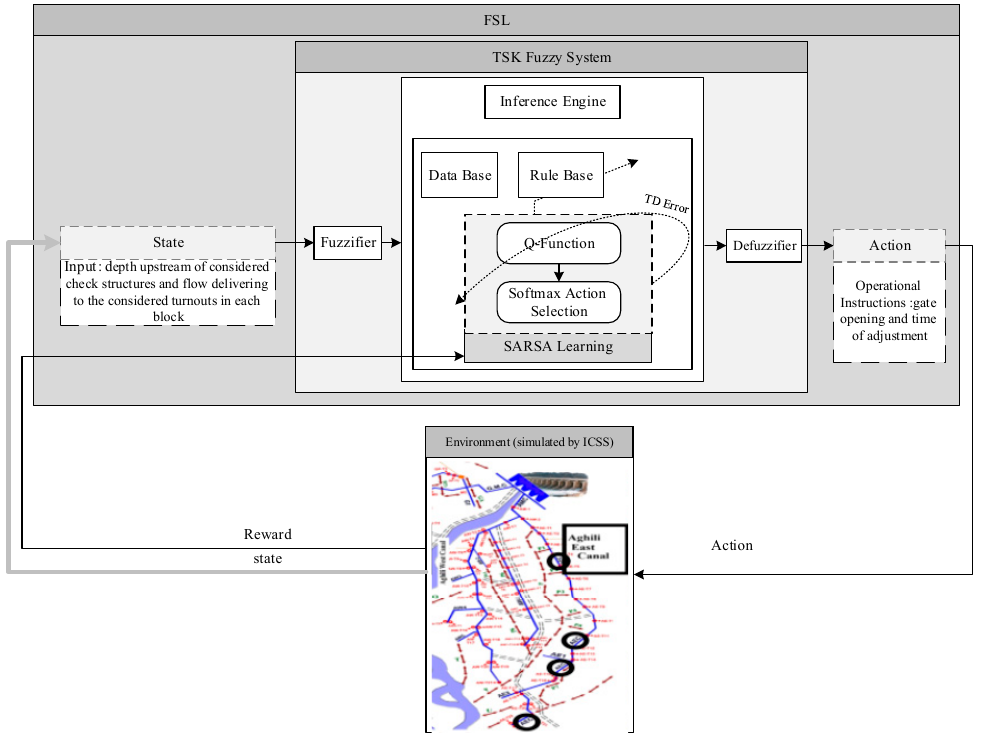
Figure 3. A simplified diagram of the system and the learning method.